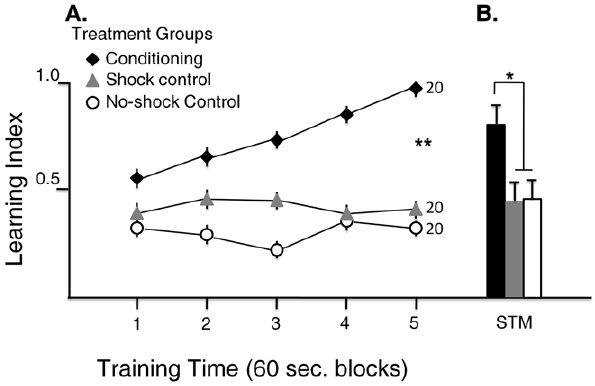
Figure 2. Learning and memory tests for bees in the groups for avoidance conditioning, none-shock control, and shock con- trol. The avoidance conditioning treatment served as the conditioning control in other experiments where influence of biogenic amines on learning and memory were tested. A. Learning: Bees in the avoidance conditioning group demonstrate a significant learning effect as indicated by increase in learning index over the 5 minute training period. This is in contrast to the none-shock and shock control groups with no evidence of improved avoidance where either no shock was applied or shock was applied to both halves of the apparatus. In repeated measures MANOVA, the conditioning group vs the control groups are significantly different (F=11.09, df=2, P , 0.001). The change in learning index over time showed significant difference based on group (Repated measures MANOVA, time blocks (5) and groups (3) interaction: F=2.28, df=8, P , 0.03). B. Short term memory (STM) test : In the STM test performed 20 minutes after the second training bout, the conditioning group bees scored high for learning index (mean 6 SE=0.80 6 0.09, N=20) similar to the end of training period, and statistically significantly different than the control group bees ( none-shock control: mean 6 SE=0.46 6 0.1, N=20; shock control mean 6 SE=0.44 6 0.1, N=20; ANOVA for STM learning index: df=2, F=3.9, p , 0.03).